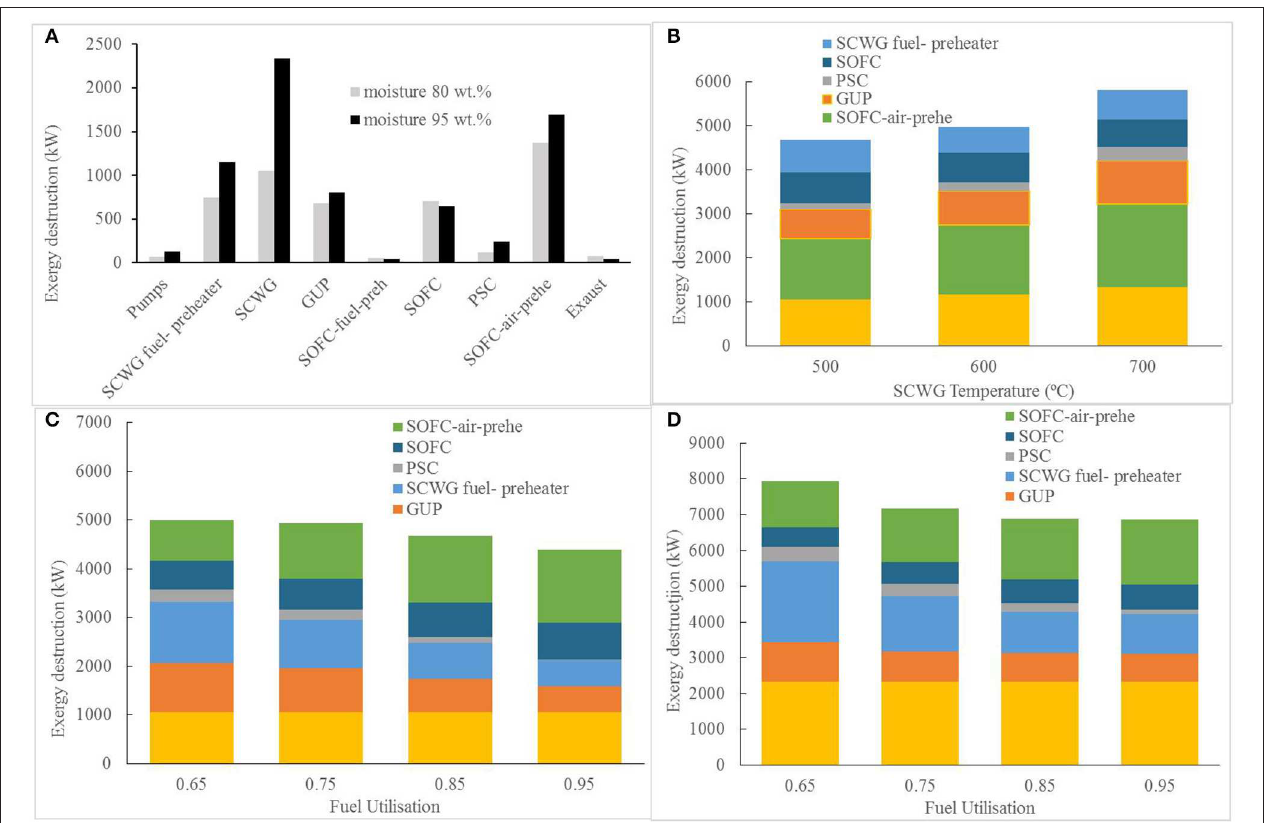
FIGURE 6 | Exergy destruction attribution of each section to the total exergy loss as a function of: (A) 80 and 95 wt.% biomass moisture (B) gasifier temperature (C) U f in supercritical water gasification (SCWG)-solid oxide fuel cell (SOFC) system at 80 wt.% and (D) U f in SCWG-SOFC system at 95